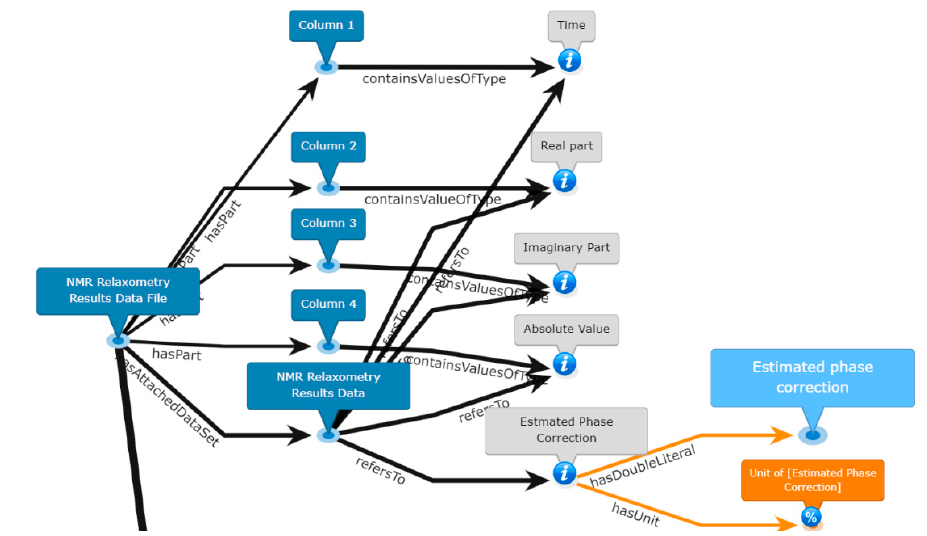
Figure A2. Zoom on Figure 9 Area 2: Description of the results data file.